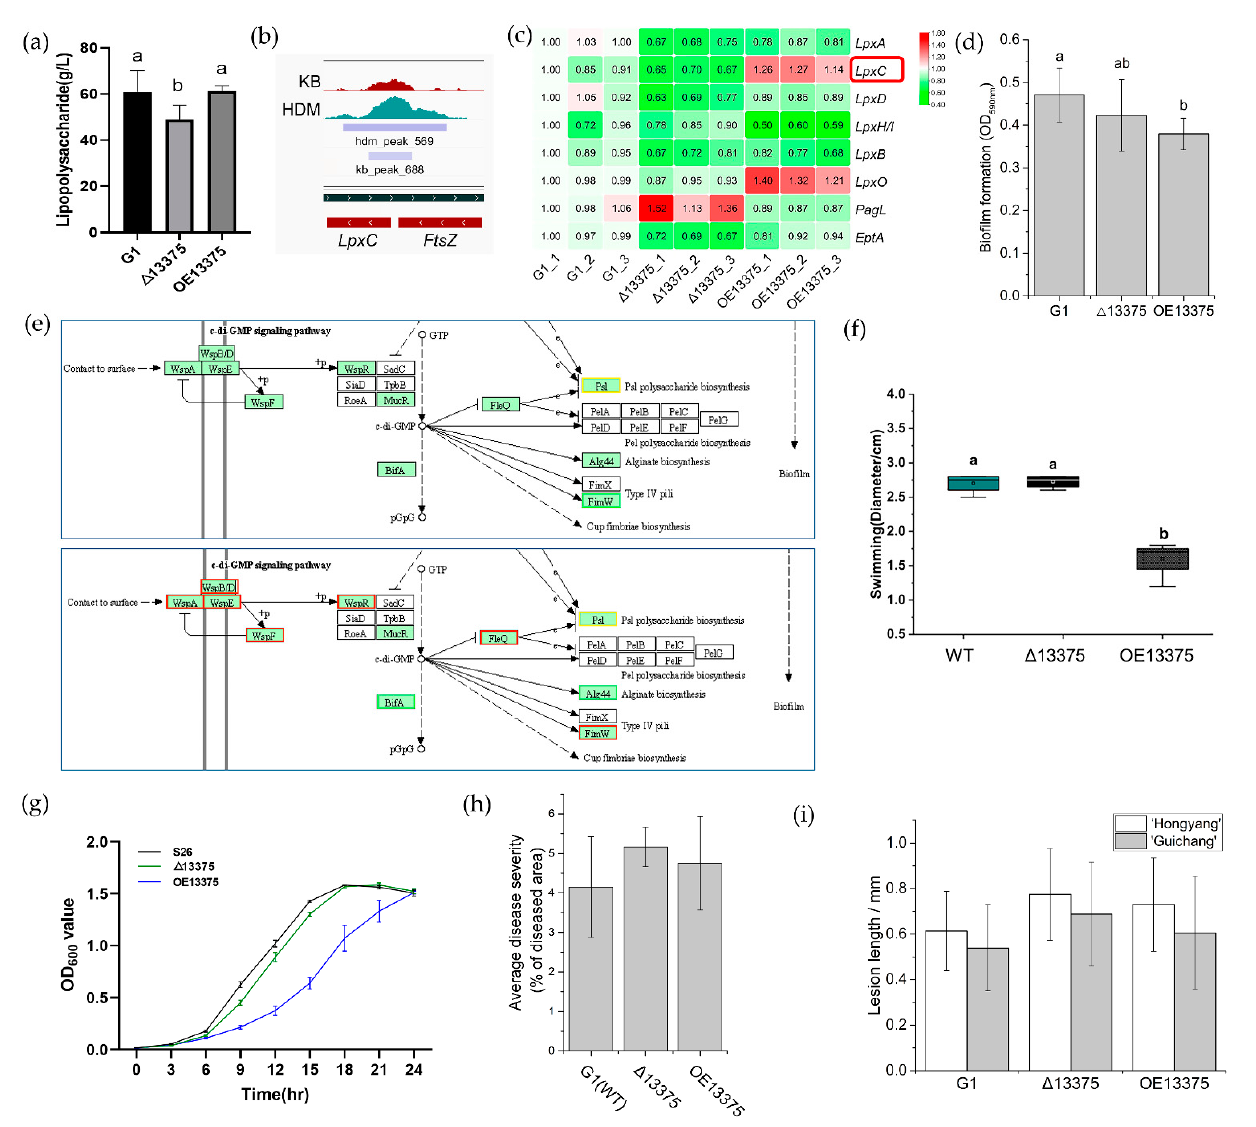
Figure 4. The OmpR-like transcription factor is also involved in other Psa biological pathways. ( a ) The lipopolysaccharide content in G1, Δ 13375, and OE13375; ( b ) original sequence peaks show the OmpR-like-binding regions in the lpxC promoter; ( c ) the differentially expressed genes related to lipopolysaccharide formation in Δ 13375 and OE13375 were revealed by RNA-seq analysis; ( d ) the capacity of biofilm formation in G1, Δ 13375, and OE13375; ( e ) the transcription of biofilm formation pathway genes in Δ 13375 and OE13375; ( f ) swimming motility of G1, Δ 13375, and OE13375 and diameter measurements of halos obtained when strains with the same OD 600 nm values were titrated on KB plates containing 0.3% agar and incubated within 24 h at 25 °C; ( g ) standard curves of G1, Δ 13375, and OE13375 in LB medium were drawn by measuring the optical density at 600 nm of the bacterial suspension every 3 h; ( h ) virulence quantification of G1, Δ 13375, and OE13375, obtained by calculating the average disease severity (ratio of diseased area to the total area of the leaf disc); ( i ) pathogenicity of G1, Δ 13375, and OE13375 on woody canes of different kiwifruit varieties (“Hongyang” and “Guichang”), determined by the wound-inoculation method. The lesion length was measured 20 days after inoculation. G1: wild-type strain; Δ 13375: OmpR-like deletion mutant; OE13375: OmpR-like overexpression mutant. The difference among samples were determined by least significant difference (LSD) tests for multiple comparisons, and different lowercase letters in indicate significant differences at p <